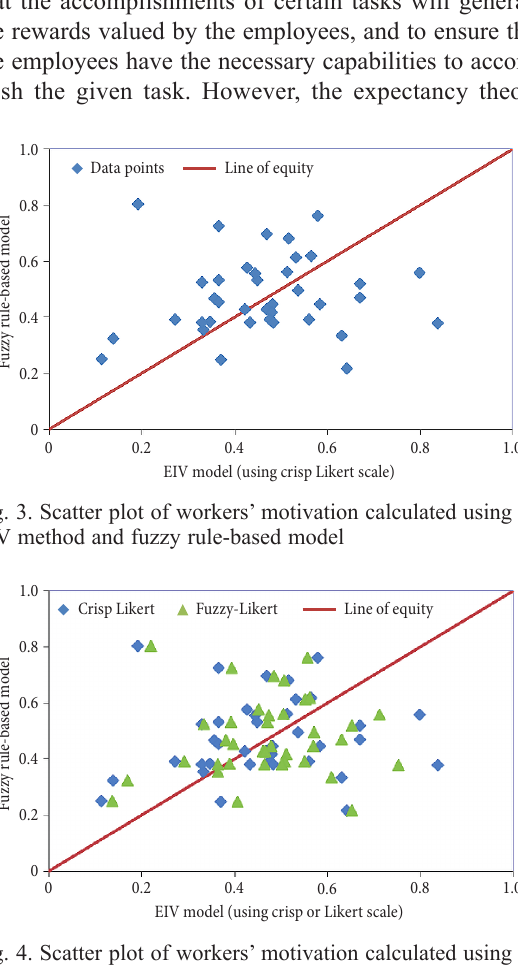
Fig. 4. Scatter plot of workers’ motivation calculated using fuzzy rule-based model and Likert EIV or fuzzy-Likert EIV